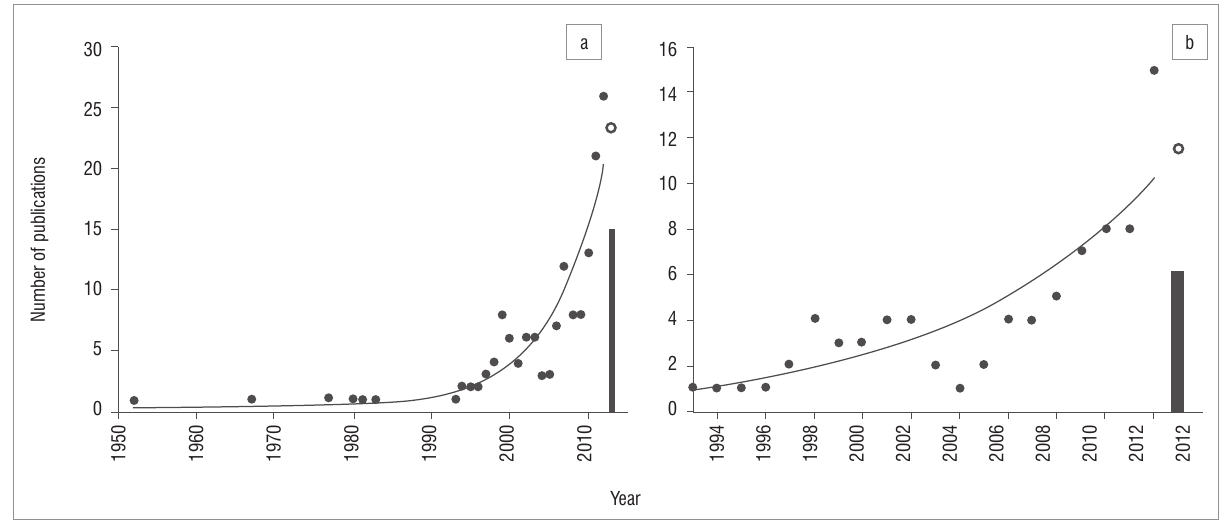
Figure 2: Number of articles published in peer-reviewed scientific journals (a) from 1952 to June 2013 that included use of video sampling techniques and (b) from 1994 that included use of stereo-video sampling techniques. The bars indicate the number of articles published by July 2013, while the open circle indicates the expected number of published articles by the end of 2013. The articles were collated by means of academic publication search engines (Academic Search Premier, Cambridge Journals, CSIRO, ESA, JSTOR, Google Scholar, Inter-Research, Science Direct, Sci-Verse Scopus, Springer Link, Web of Knowledge) and reference list reviews of key literature. Search terms entered included: BRUVs, RUVs, DOVs, remote video and fish. Studies using remotely operated vehicles and autonomous underwater vehicles and those with data collected beyond the continental shelves were